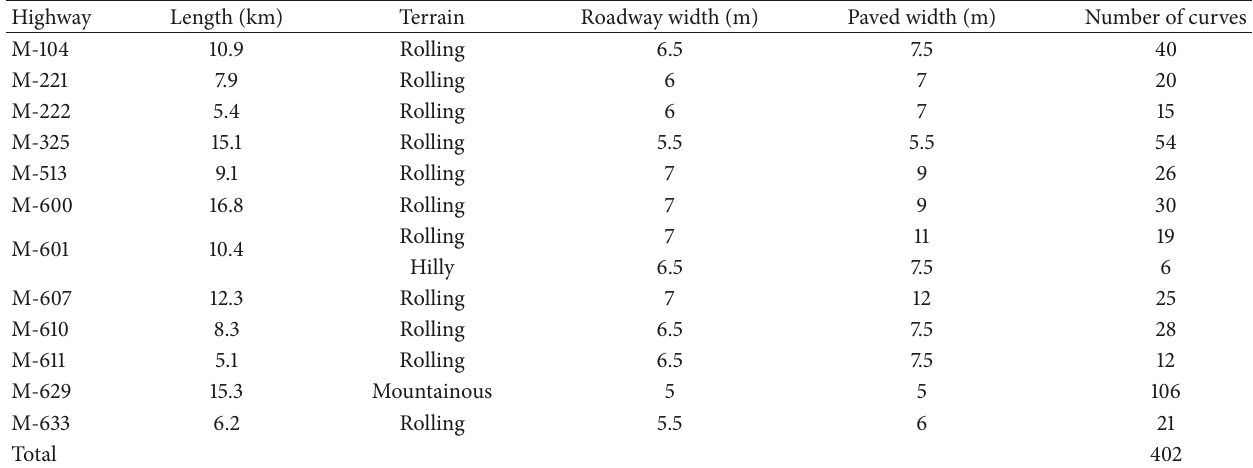
Table 1: Main features of the selected